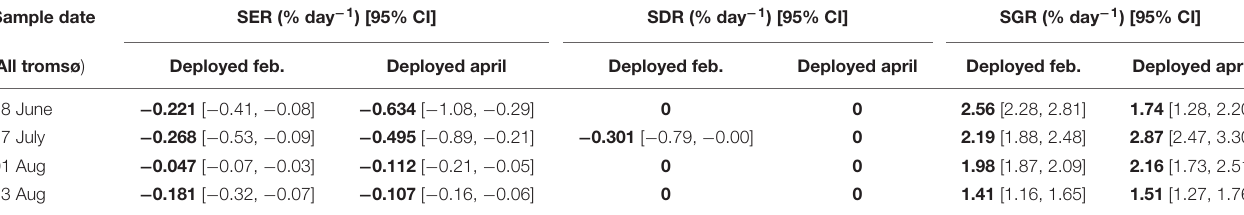
TABLE 4 | Comparison of specific rate s of erosion (SER), dislodgement (SDR), and growth (SGR) between Tromsø February and Tromsø April